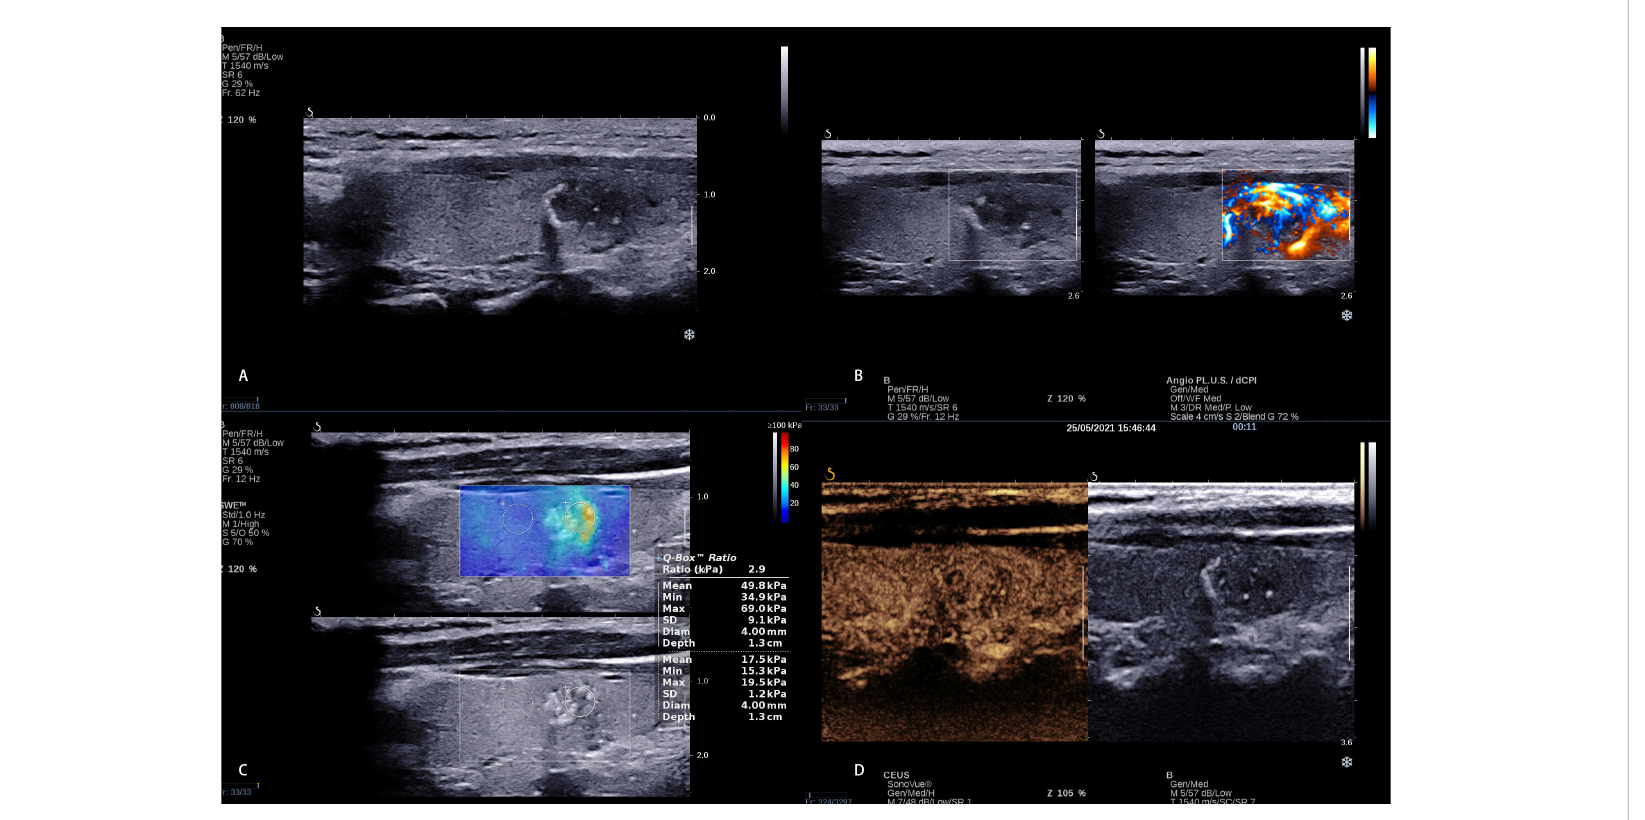
FIGURE 4 A 13 × 7 mm thyroid nodule in the right lobe of a 31-year-old woman. (A) Conventional ultrasound showed a solid hypo-echoic, ill-de fi ned nodule with calci fi cations; the shape was wider than taller and the contact extent with adjacent thyroid capsule <25%. (B) AP shows that the vascularization of nodule could be classi fi ed as Grade II. (C) SWE measurement shows that Emin, Emean, and Emax were 34.9 kPa, 49.8 kPa, and 69.0 kPa, respectively. (D) CEUS shows continuous capsule at CEUS. The calculated predictive value with the logistic regression formula was 0.673 (<2.0805), which predicted no